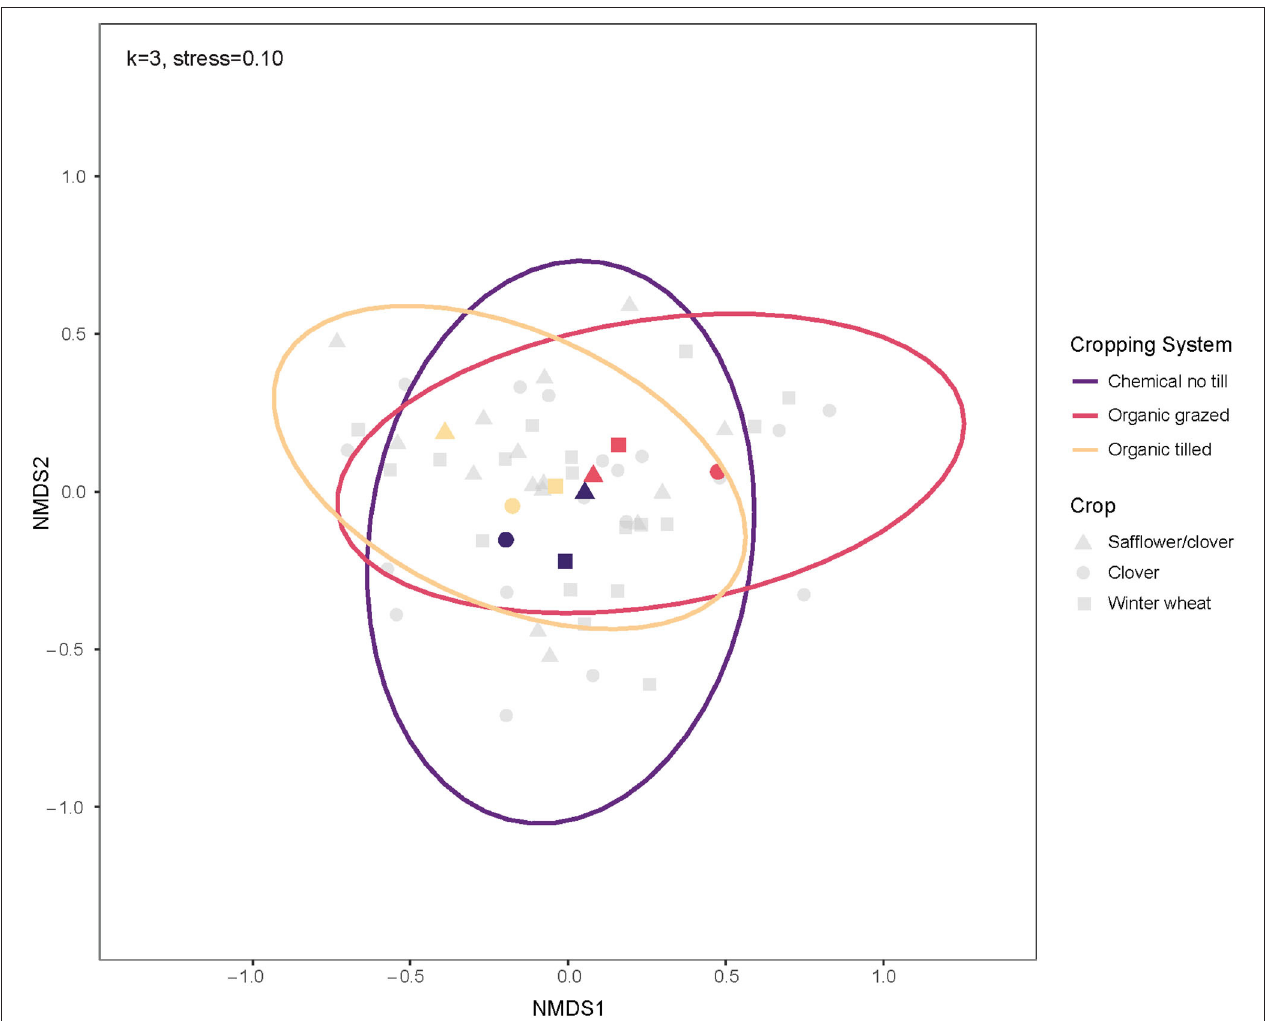
FIGURE 5 | Ordination of soil bacterial communities by crop for three contrasting dryland cropping systems using non-metric multidimensional scaling on weighted Bray-Curtis dissimilarities. The centroids and multivariate t-distribution ellipses for bacterial communities in the three cropping systems are designated by color for cropping system and shape for soil growing clover (circles), safflower/clover (triangles), or winter wheat (squares). For the NMDS calculation, k = 3, and stress =